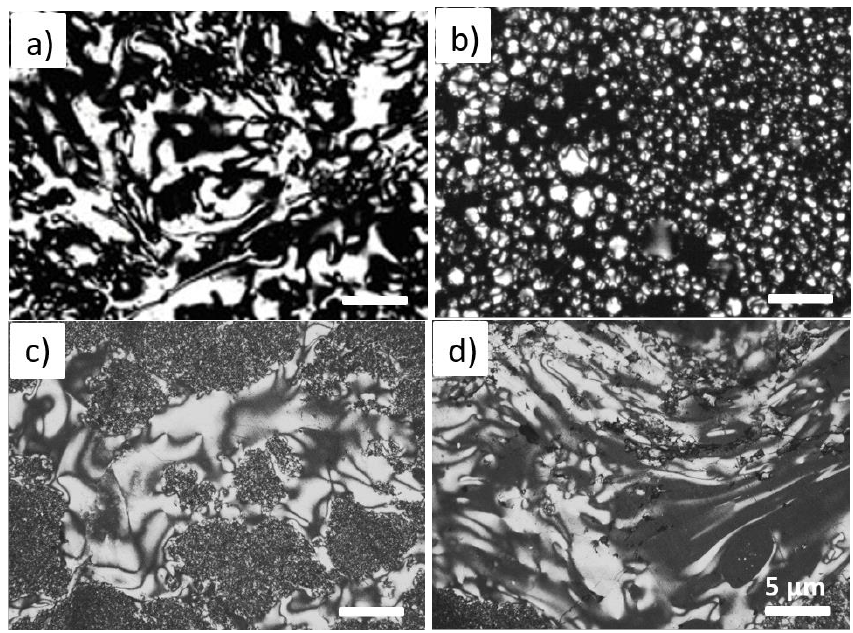
Figure 2. The polarized photomicrograph of mosophase of raw CTP ( a ), mCTP-1 ( b ), mCTP-5 ( c ) and m-CTP-9 ( d ) materials at 500 °C for 2 h, respectively. Scale bar are 5 μm for all.